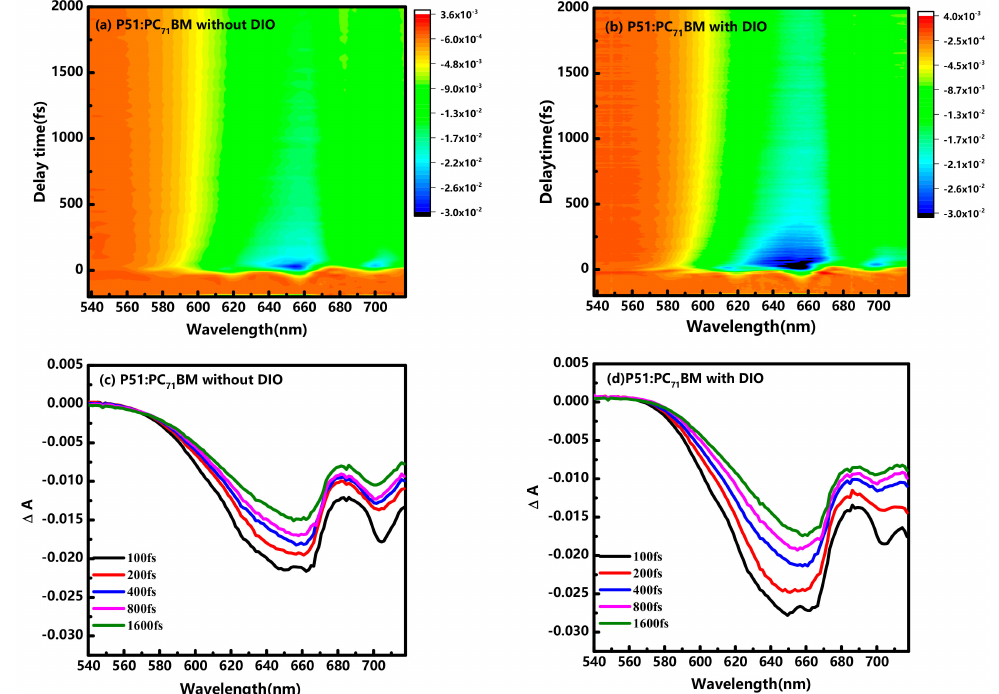
Figure 4. Two-dimensional plot of transient di ff erence absorption ∆ A( λ , t) and ∆ A( λ ) spectra at various time delays for ( a , c ) P51:PC 71 BM without DIO additives and ( b , d ) P51:PC 71 BM with DIO additives.